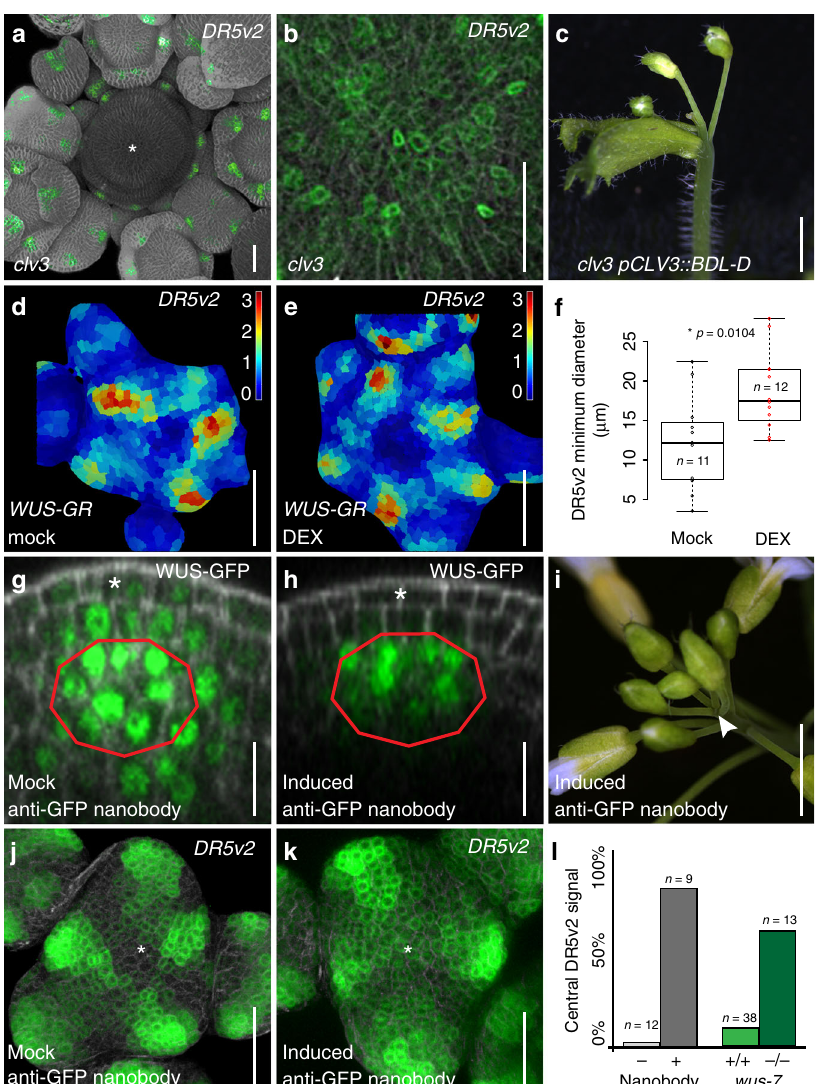
Fig. 4 WUSCHEL maintains low auxin signaling output in stem cells. a pDR5v2:ER-mCherry-HDEL activity in SAM of clv3 mutant. Asterisk marks center of SAM. b Zoom into central SAM area of clv3 mutants reveals basal pDR5v2 activity. c SAM arrest caused by pCLV3:BDL-D expression in clv3 . d , e Representative pDR5v2:ER-eYFP-HDEL signals after 24 h of mock treatment ( d ) or inducible ectopic activation of WUS-GR activity ( e ). f Quanti fi cation of central DR5v2 signal minimum size in µ m following ectopic WUS activation. p -value derived by t -test. g , h Representative images of a pWUS:WUS-linker- GFP rescue line expressing the anti GFP nanobody under the control of pCLV3:AlcR ( wus/pWUS:WUS-linker-GFP/pCLV3:AlcR/pAlcA:NSlmb-vhhGFP4) . g WUS-linker-GFP signal after 24 h of mock treatment. h WUS-linker-GFP signal after 24 h of WUS depletion. Red lines mark WUS mRNA expressing